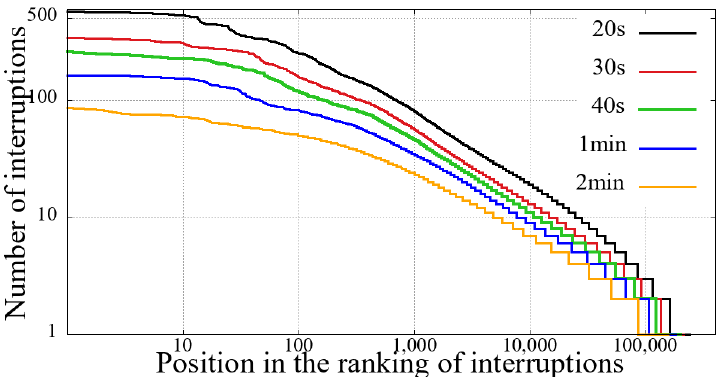
Figure 3. Interruption ranking from users of the Impeachment start session— Camara dos Deputados for different sizes of interruption—non-mobile devices.